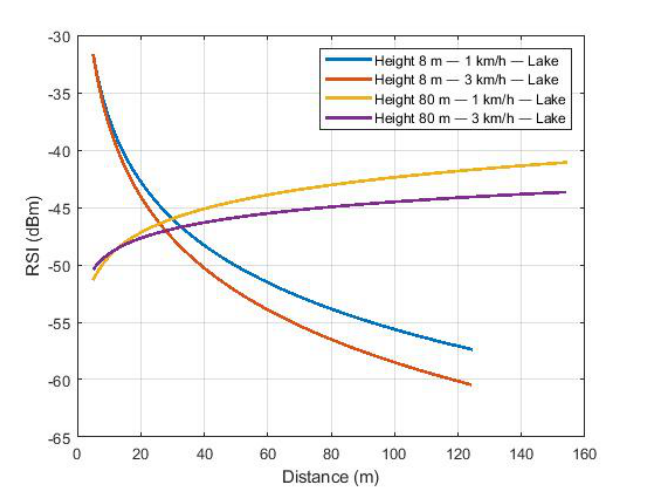
Figure 6. Path loss of flights over the